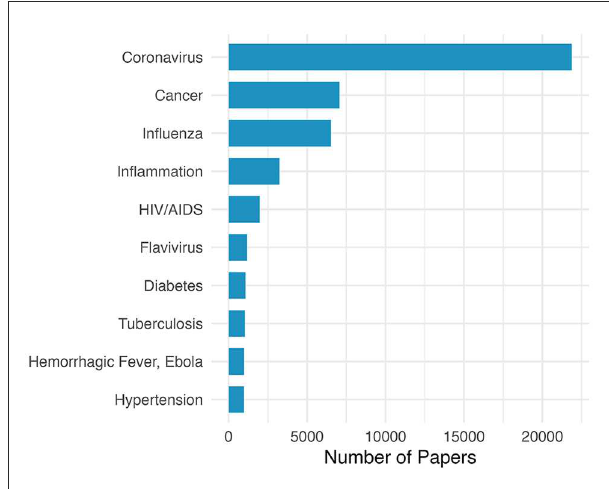
FIGURE1 Research expertise of COVID-19 vaccine top authors.